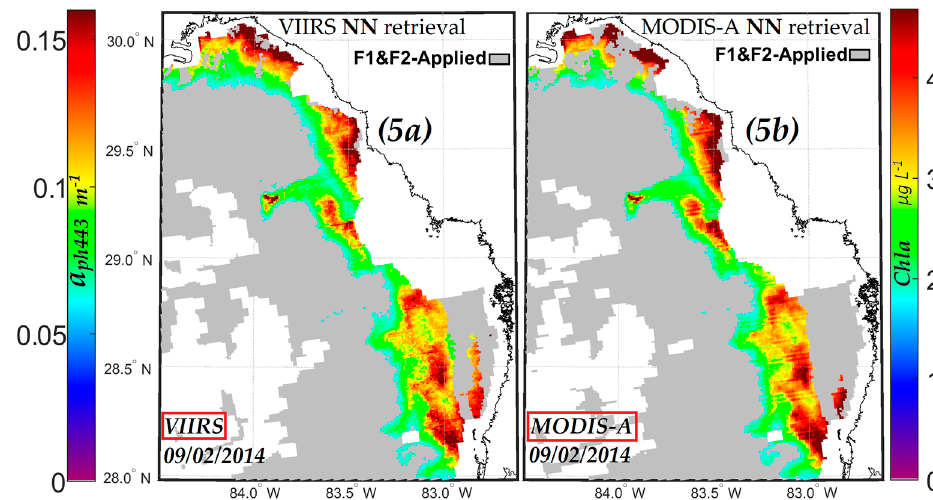
Figure 5. ( a ) Shows VIIRS retrieved NN a ph 443 (left hand scale) and equiv. [ Chla ] (right hand scale) after filter process masks F1 and F2 are applied. These residual values are therefore compatible with and show the extent of the KB blooms; ( b ) MODIS-A NN retrieved a ph 443 (left hand scale) and equiv. [ Chla ] (right hand scale) after filter process masks F1 and F2 are applied. Residual values are therefore compatible with and indicate KB blooms. Dark gray represents F1&F2 masks and white represents cloud cover or invalid data.